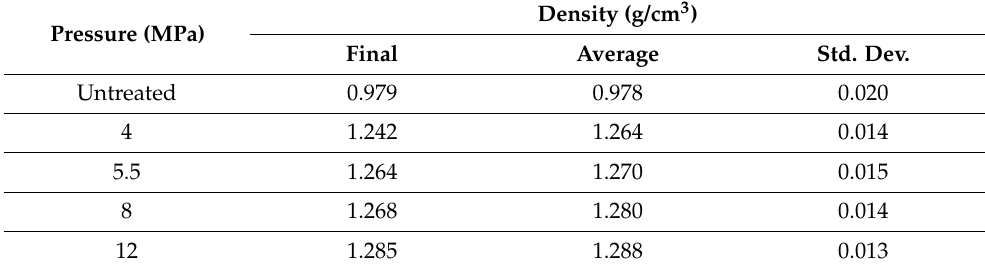
Table 2. Density of water–cellulose